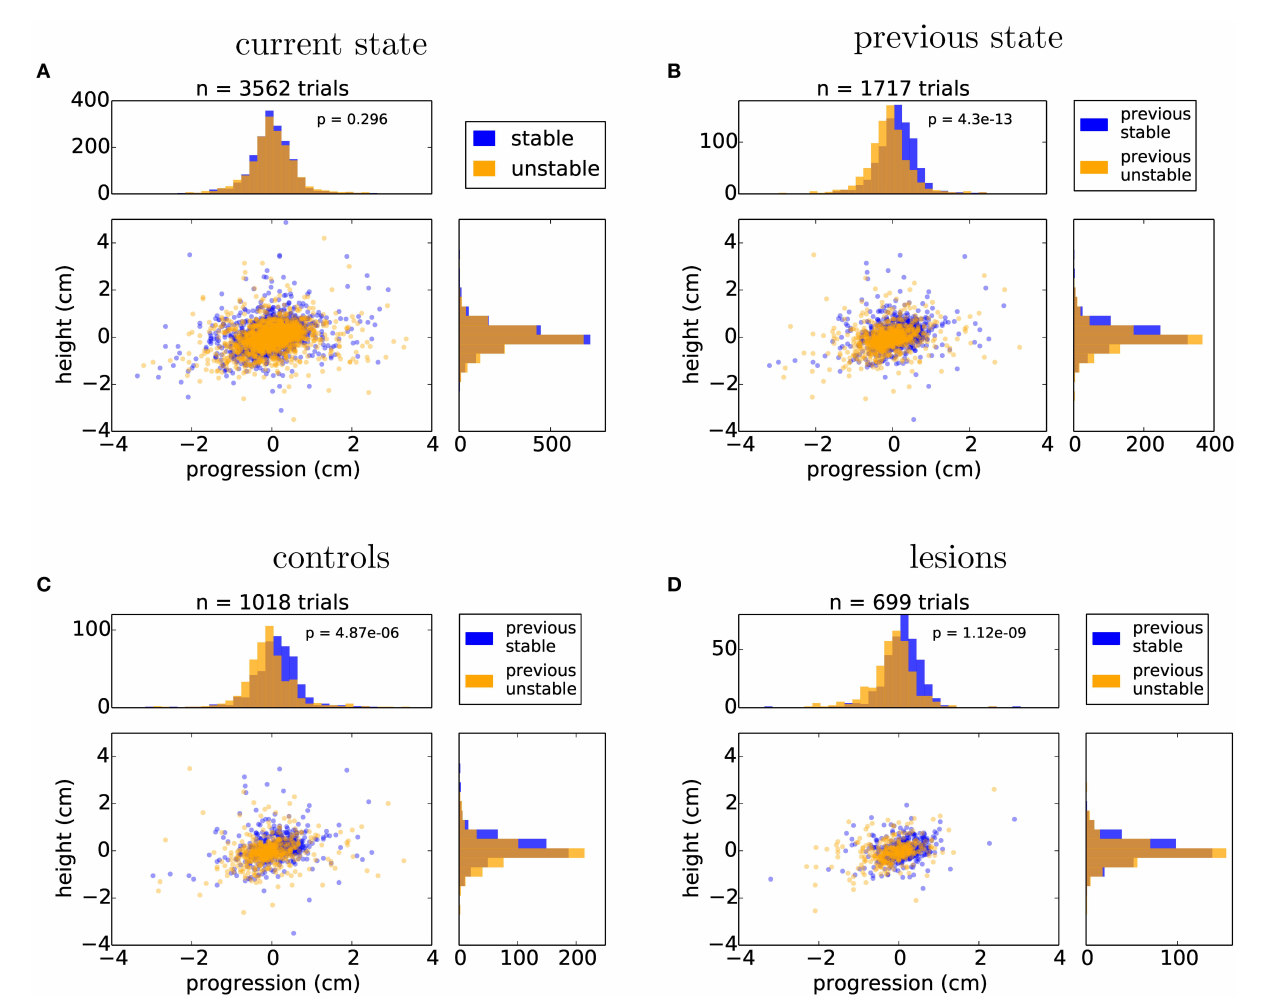
FIGURE8 Animals adjust their posture on a trial-by-trial basis to the expected state of the world. (A) Distribution of nose positions on the randomized protocol when stepping on the first manipulated obstacle, for trials in which the current state was stable (blue) or unstable (orange): average height (stable: 0.04 ± 0.59 cm, unstable: –0.02 ± 0.58 cm), average progression (stable: –0.01 ± 0.59 cm, unstable: 0.01 ± 0.64 cm). (B) Distribution of nose positions for trials in which the previous two trials were stable (blue) or unstable (orange): average height (previous stable: 0.09 ± 0.57 cm, previous unstable: –0.05 ± 0.57 cm), average progression (stable: 0.11 ± 0.56 cm, unstable: –0.10 ± 0.62 cm). (C, D) Same data as in (B) split by the control and lesion groups: controls - average height (previous stable: 0.13 ± 0.63 cm, previous unstable: -0.05 ± 0.60 cm), average progression (stable: 0.12 ± 0.59 cm, unstable: -0.06 ± 0.65 cm), lesions - average height (previous stable: 0.04 ± 0.47 cm, previous unstable: –0.06 ± 0.52 cm), average progression (stable: 0.09 ± 0.51 cm, unstable: –0.16 ± 0.57 cm). Listed values report mean ± standard deviation and p values from Student’s unpaired t-test are